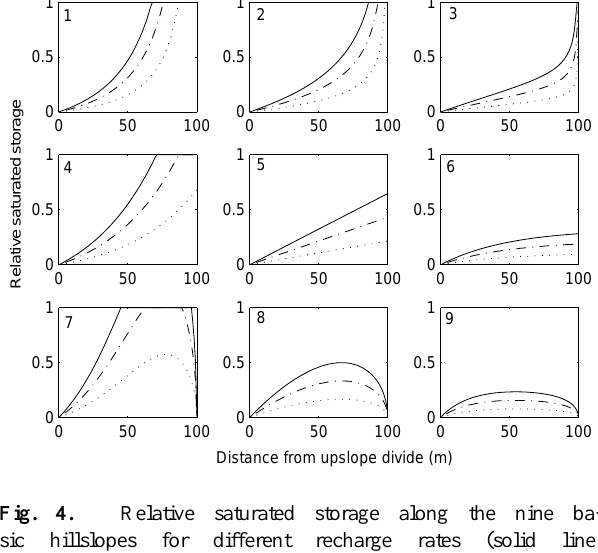
Fig. 3. Prediction of saturation zone boundary at convergent hills- lope (after Rezzoug et al., 2005)